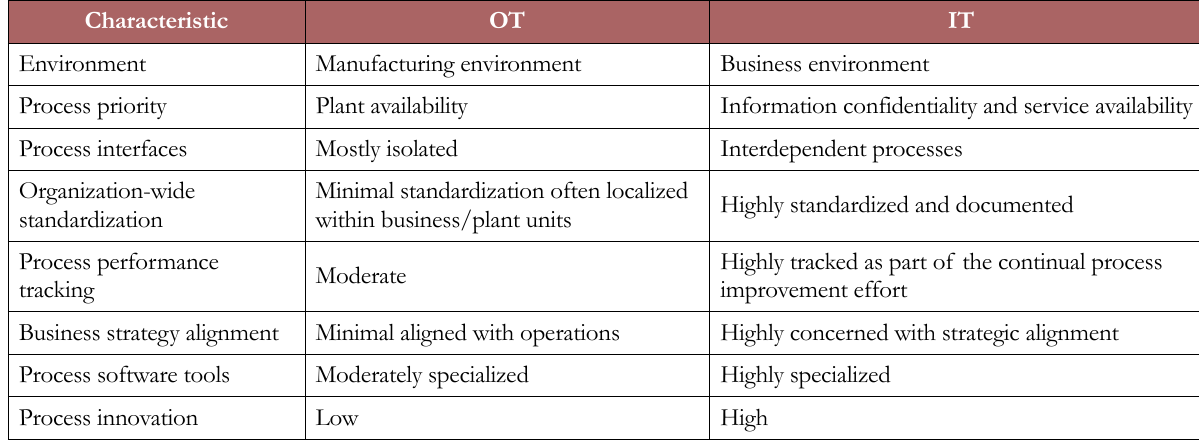
Table 2. Comparison between OT and IT